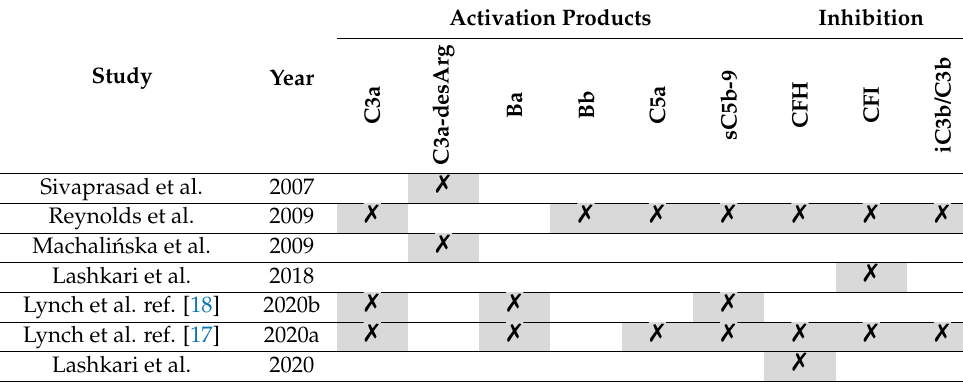
Table 2. Complement Proteins Measured in Each Meta-Analyzed Study.